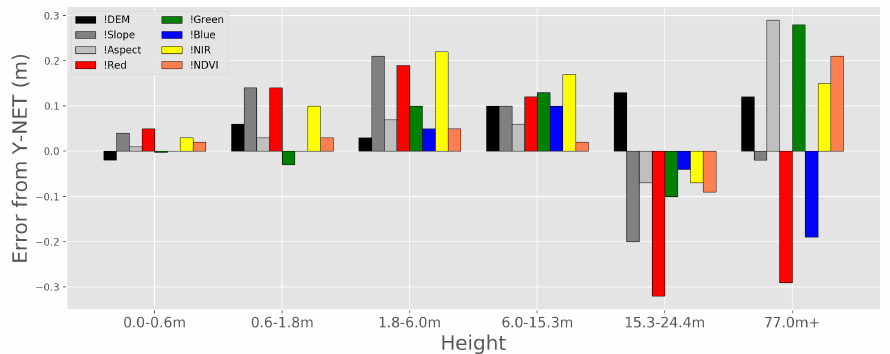
Figure 12. Performance of Y-NET when input layers are removed compared to all included. Absolute error in